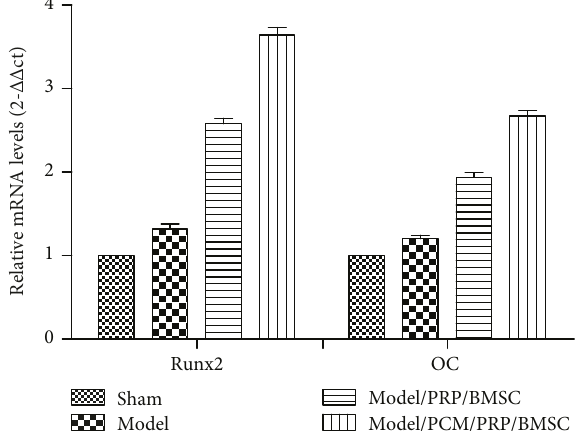
Figure 7: Expression of Runx2 and OC in rat tibia